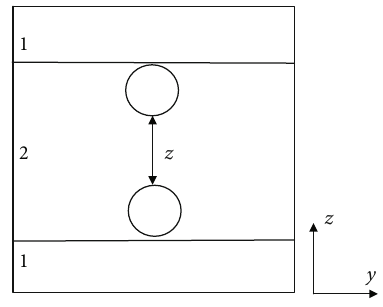
Figure 11: Distribution model of two